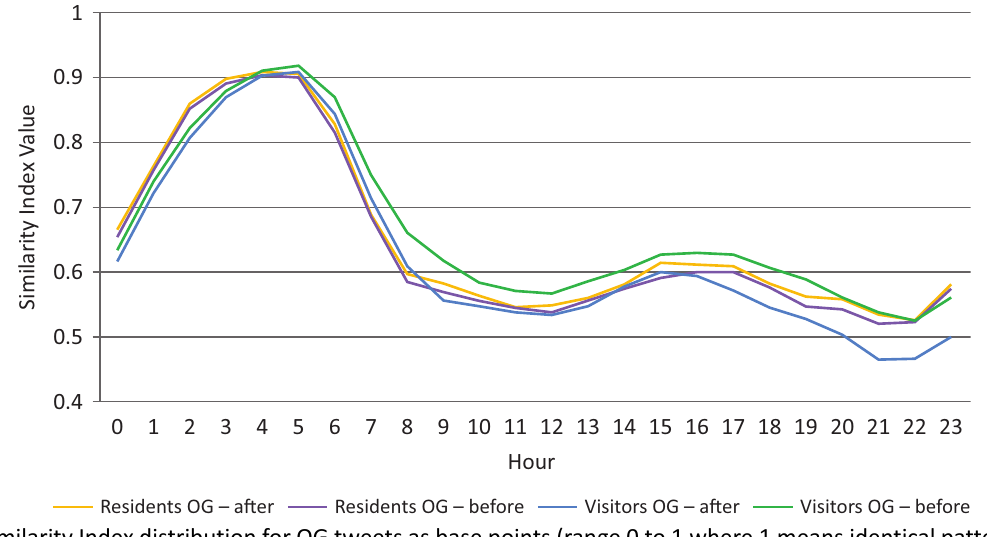
Figure 4. Similarity Index distribution for OG tweets as base points (range 0 to 1 where 1 means identical pattern for both analysis periods and 0 represents no similarity at